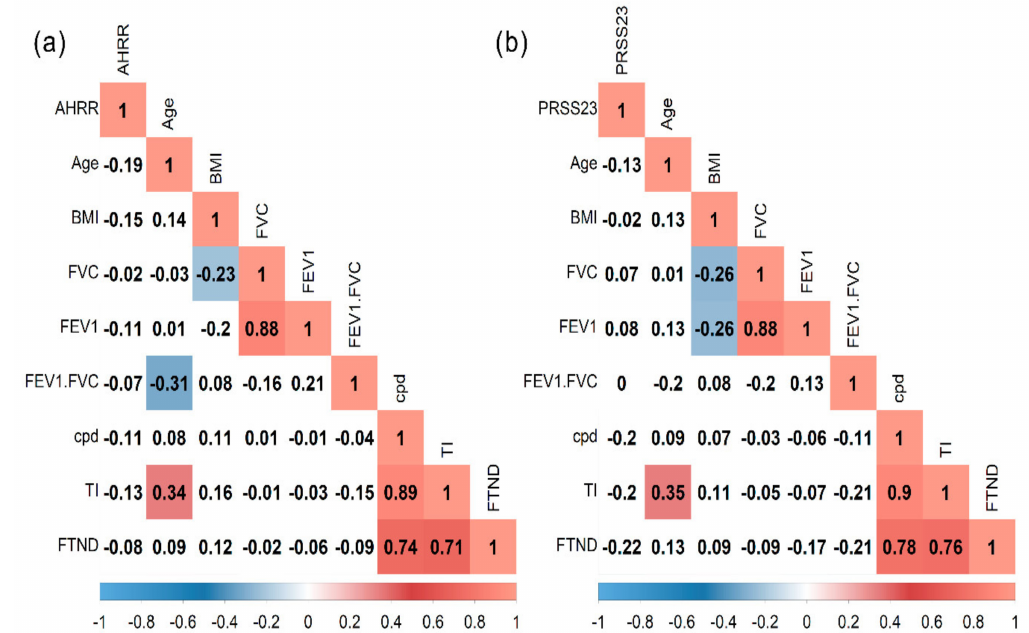
Figure 4. Spearman correlation matrix in tobacco smokers’ group. ( a ) cg05575921 ( AHRR ) site and ( b ) cg23771366 ( PRSS23 ) site. BMI, body mass index; FVC, forced vital capacity; FEV1, forced expiratory volume in the first second; cpd, cigarette per day; TI, tobacco index; FTND, Fagerström test for nicotine